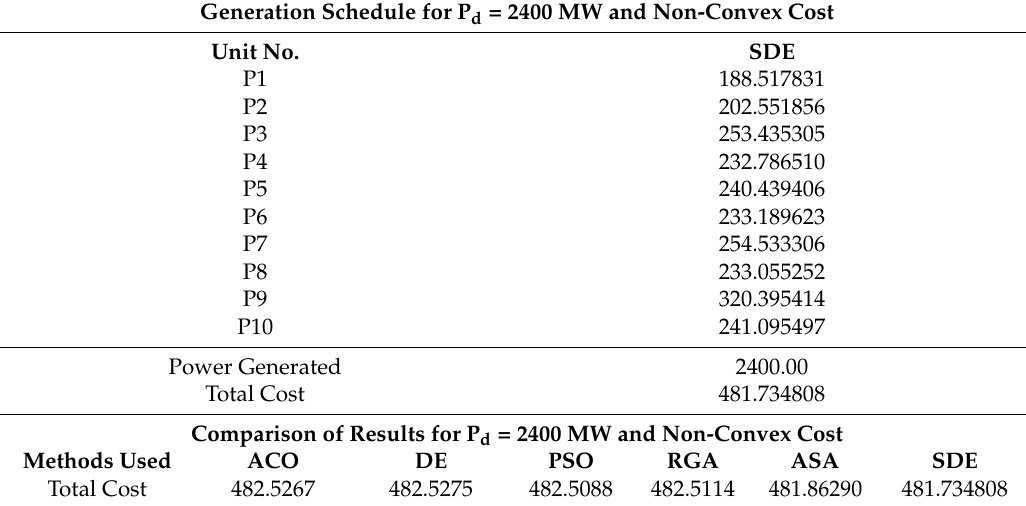
Table 9. Cost comparison among various methodologies for System 2, P d = 2400 MW. Generation Schedule for P d = 2400 MW and Non-Convex Cost